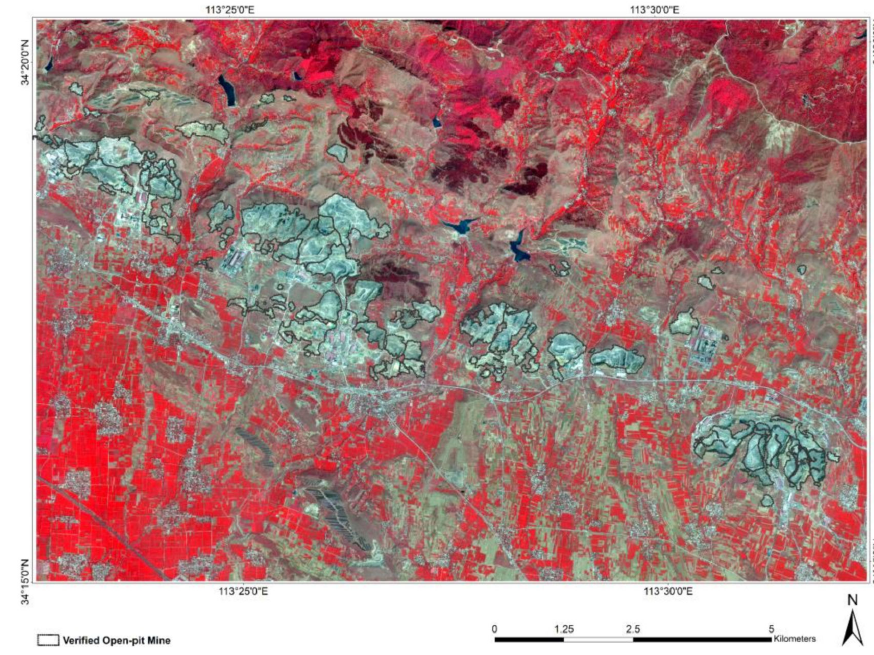
Figure 1. Location of study area (R: Band4, G: Band3, B: Band2 of GF-2